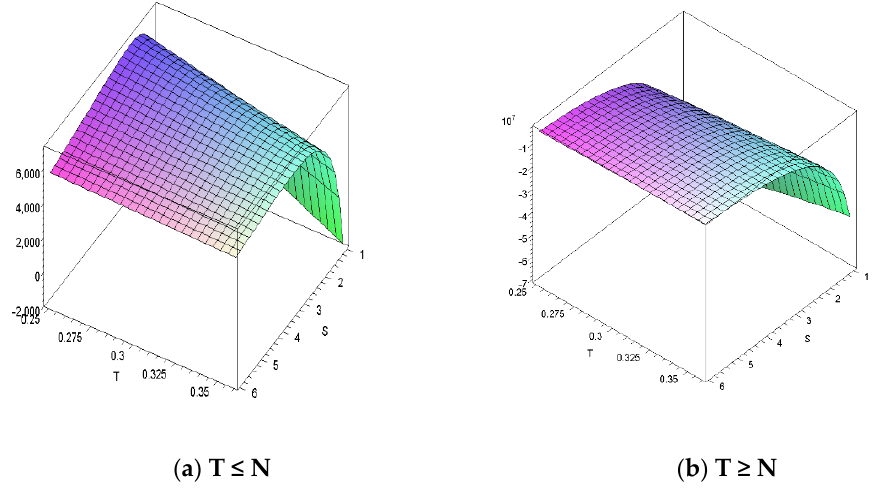
Figure 2. Representation of net income per unit time (concave function of T).